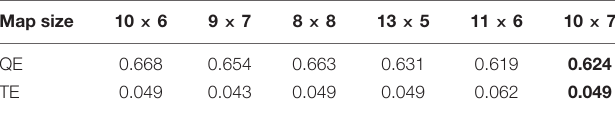
TABLE 3 | QE and TE values for deciding the optimal map size.